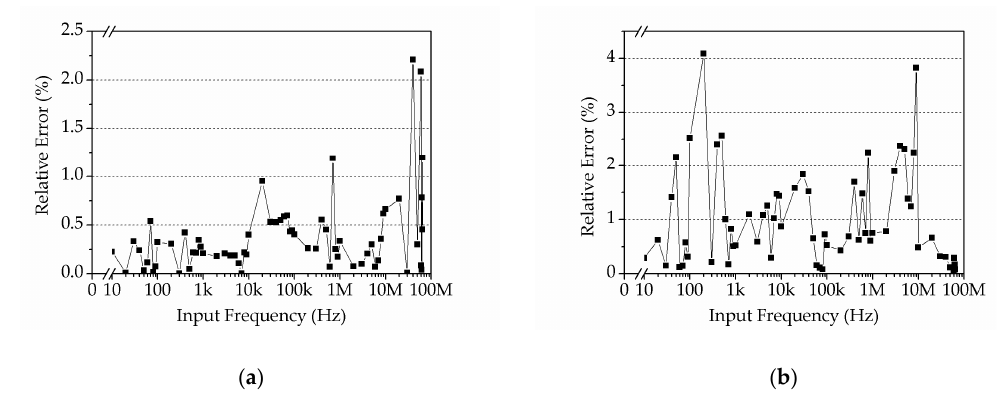
Figure 15. Relative error for the high SNR test ( a ) and low SNR test ( b ).